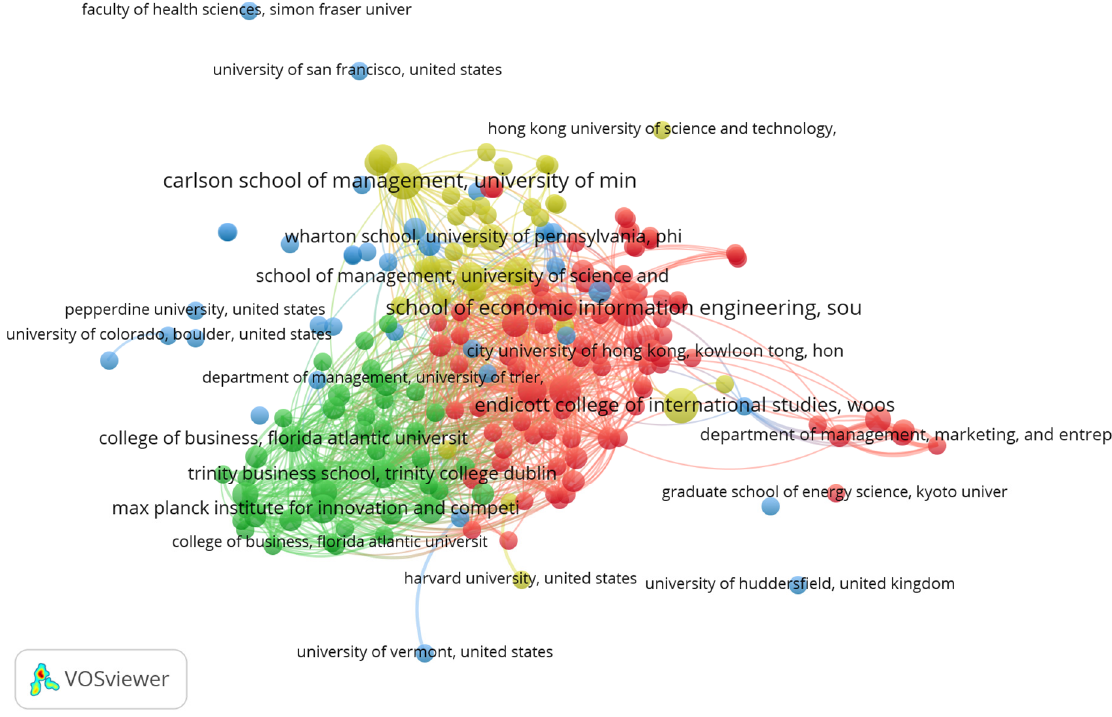
Figure 11. Co-citation analysis of